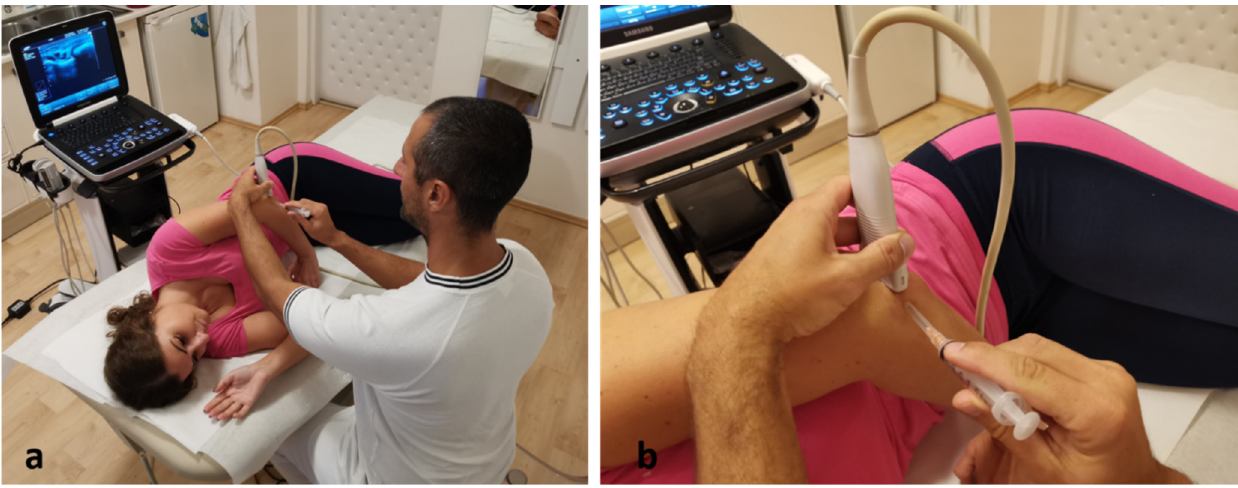
Figure 13. Ultrasound imaging and injection of the distal triceps tendinopathy: ( a ) the patient in the decubitus position with the shoulder internally rotated; ( b ) the same procedure as described before in detail—the needle is inserted from lateral to medial.